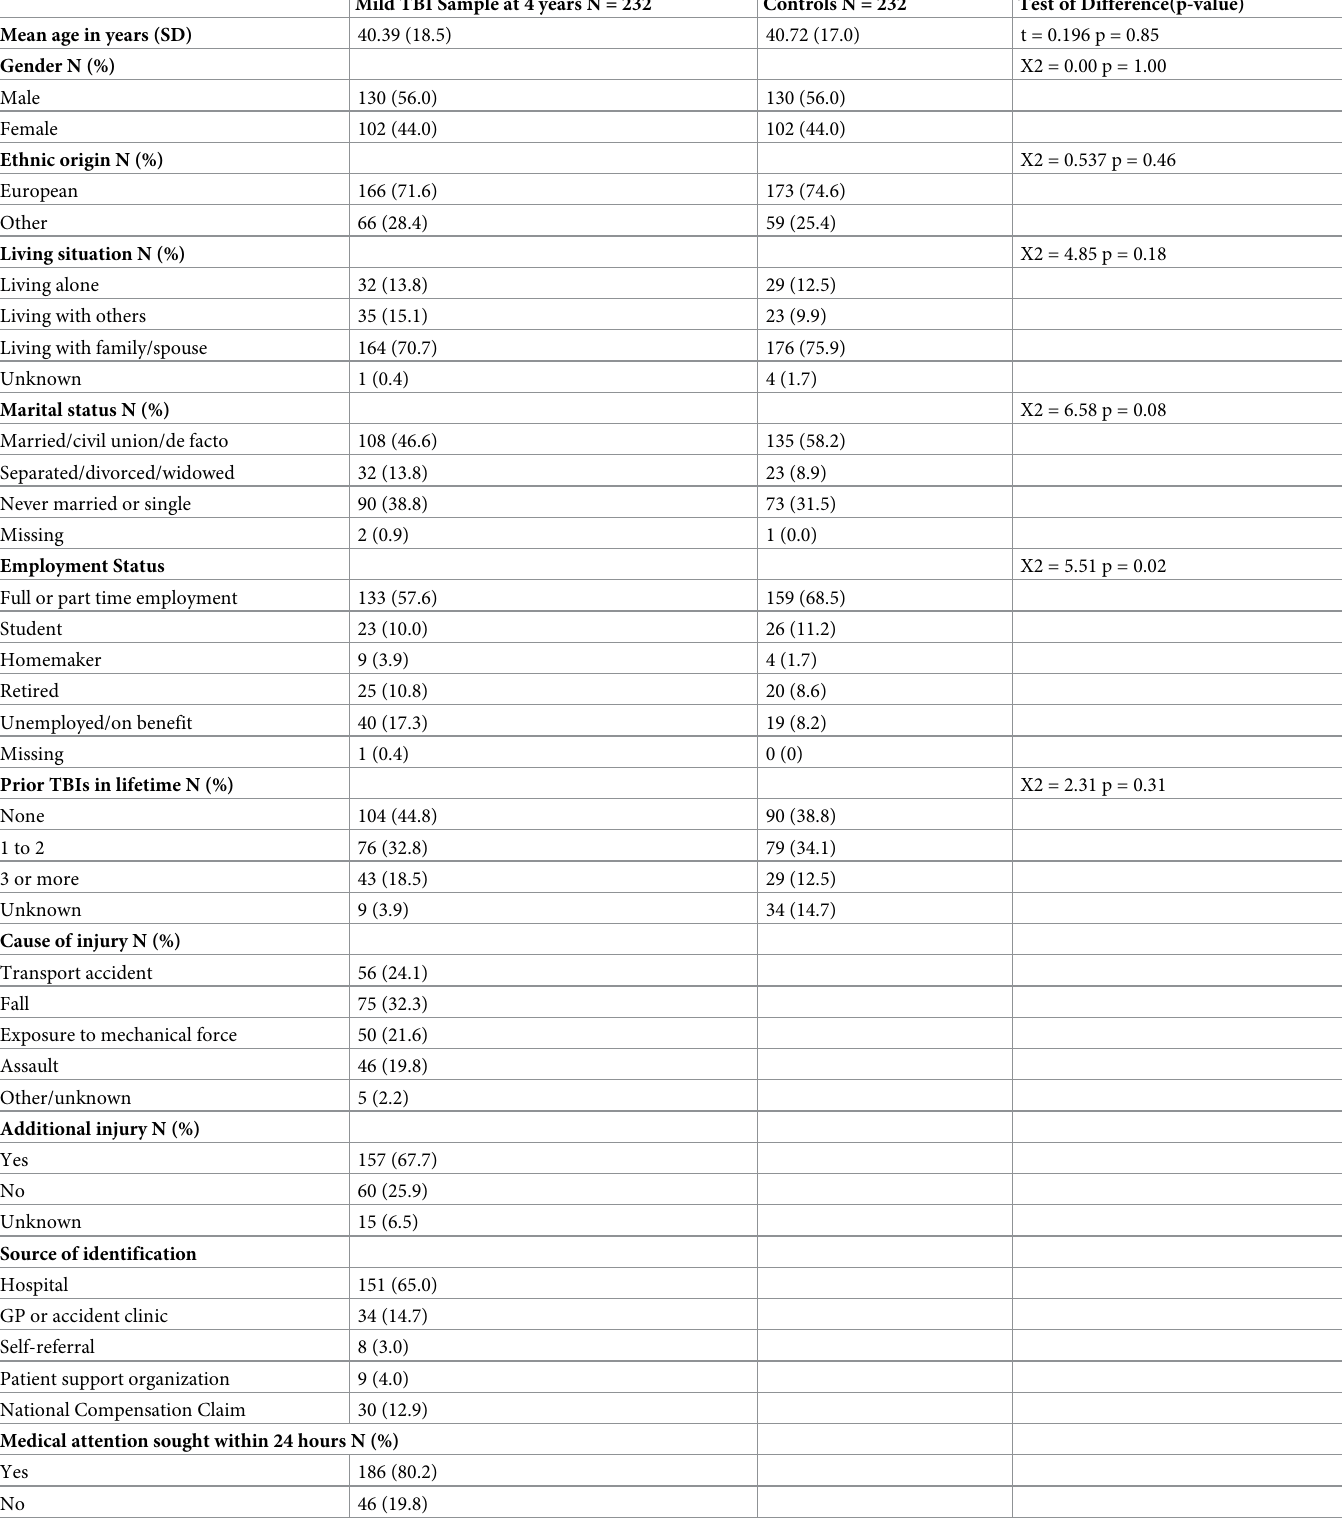
Table 1. Participant characteristics of the mild-TBI and controls